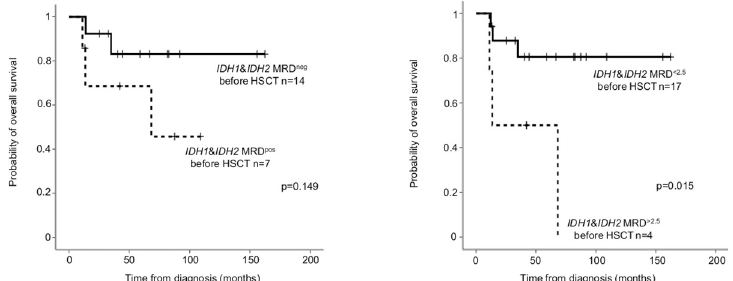
Fig 7. Probability of overall survival for IDH1/2 MRD before HSCT. On panel A, IDH1/2 MRD negativity before HSCT was defined as VAF < 0.2%, on panel B as 2.5%.